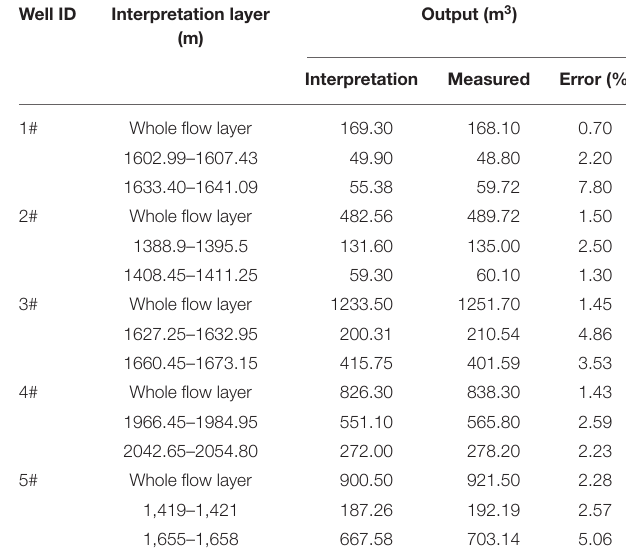
TABLE 2 | Comparison of interpreted single-phase flow with the measured